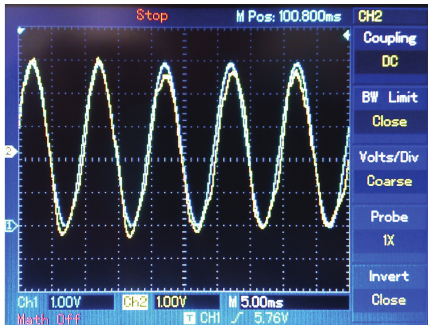
Figure 15: 70 Hz sine wave message. Blue: sent message. Yellow: retrieved message.